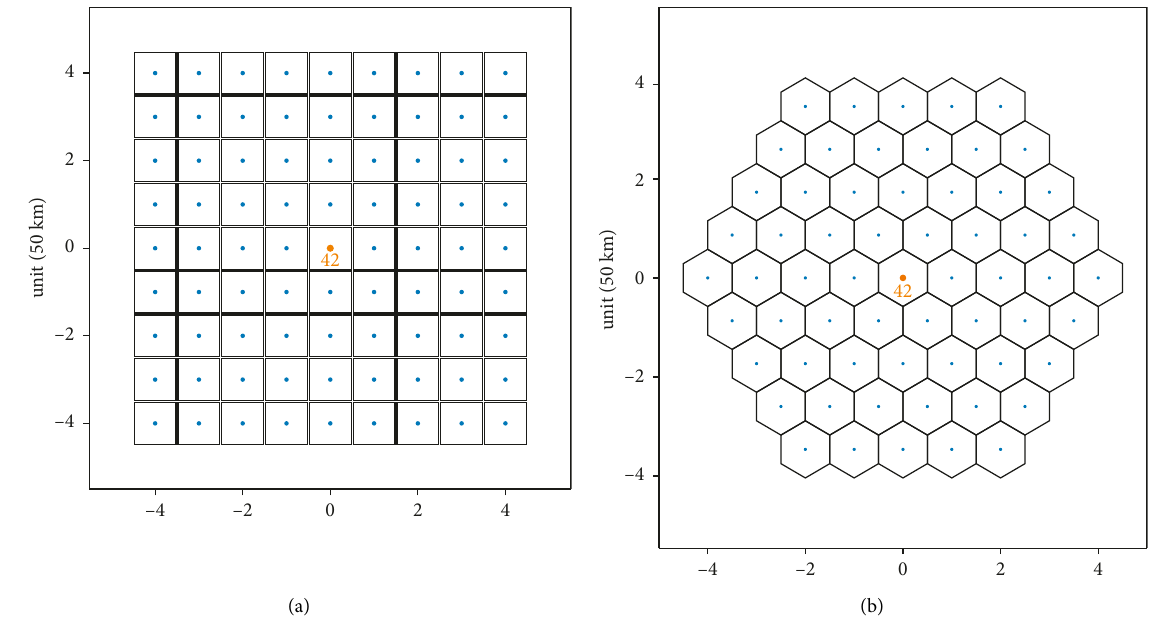
Figure 6: Distributions of candidate positions of the new navigation station. The circles are replaced by squares and hexagons, respectively. (a) Square. (b)